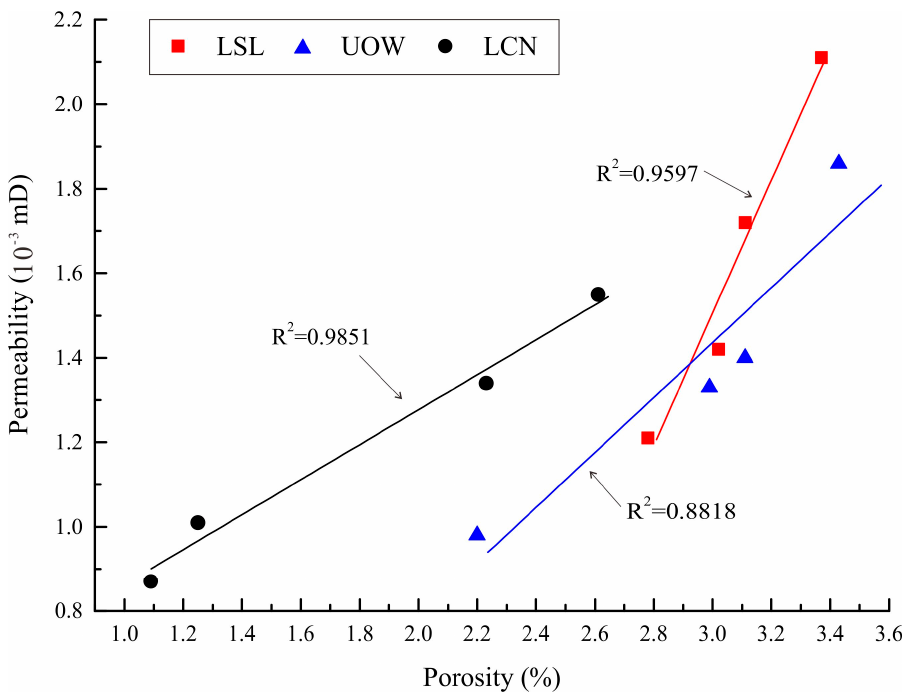
Figure 5. Linear relationships between the porosity and permeability of the collected shales.